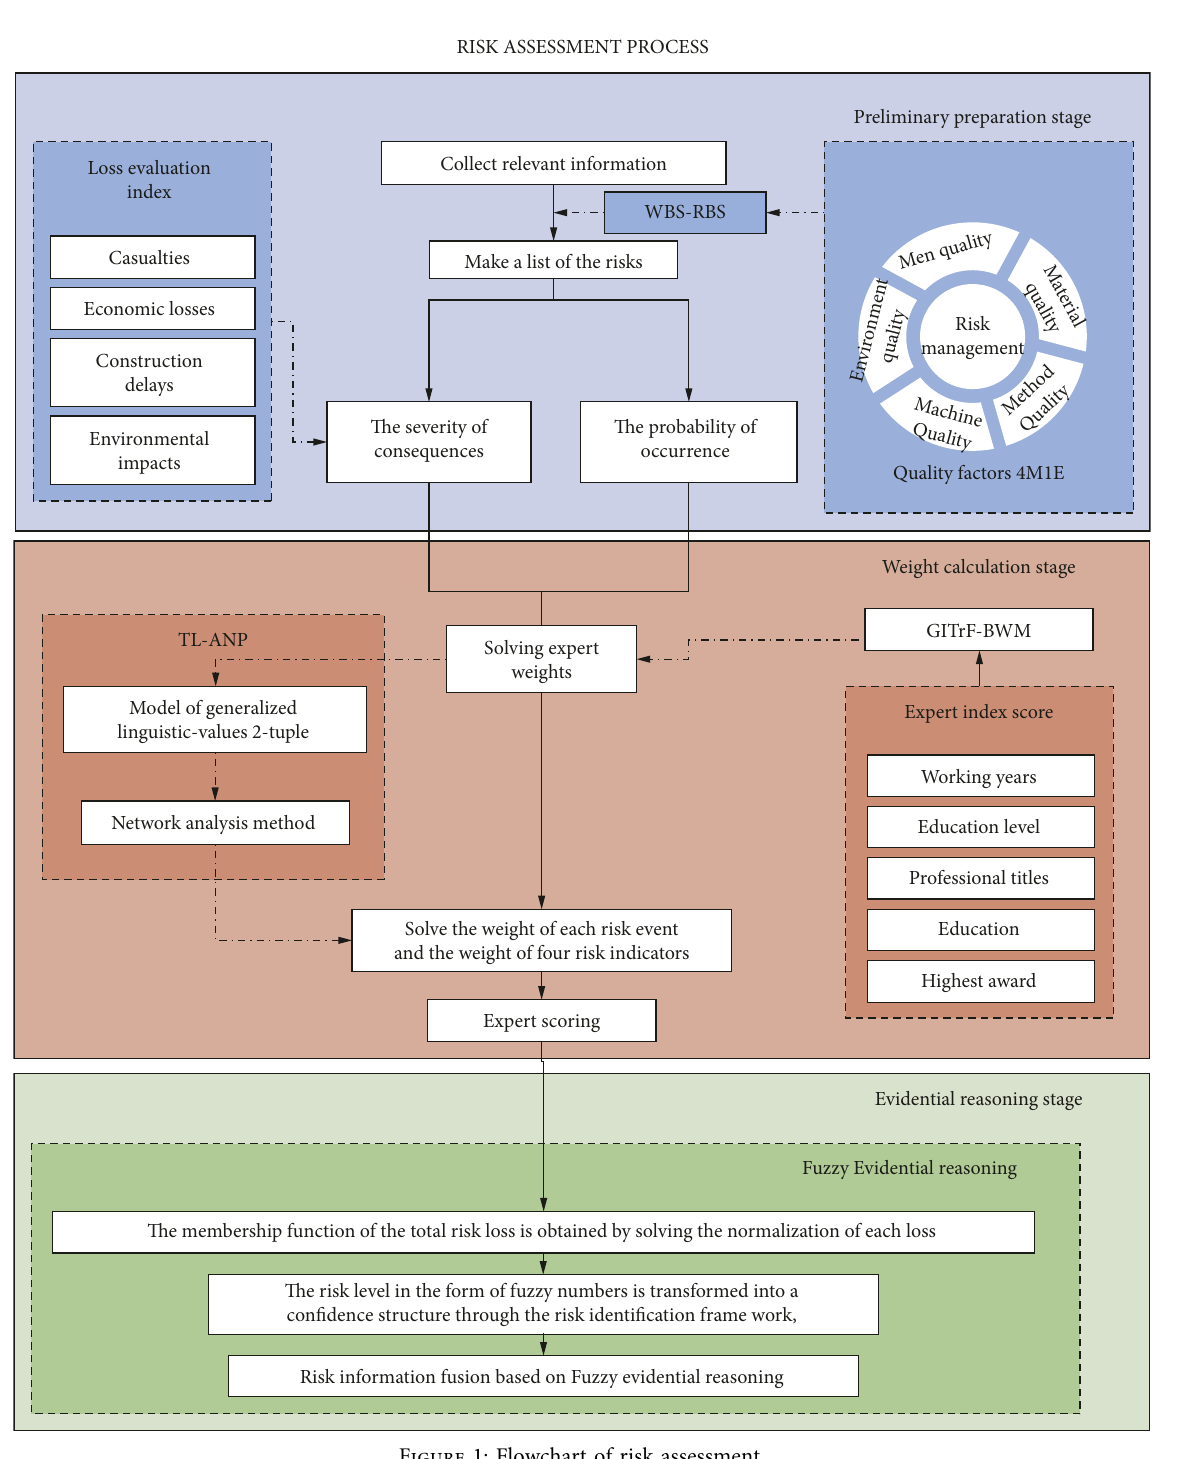
Figure 1: Flowchart of risk assessment.